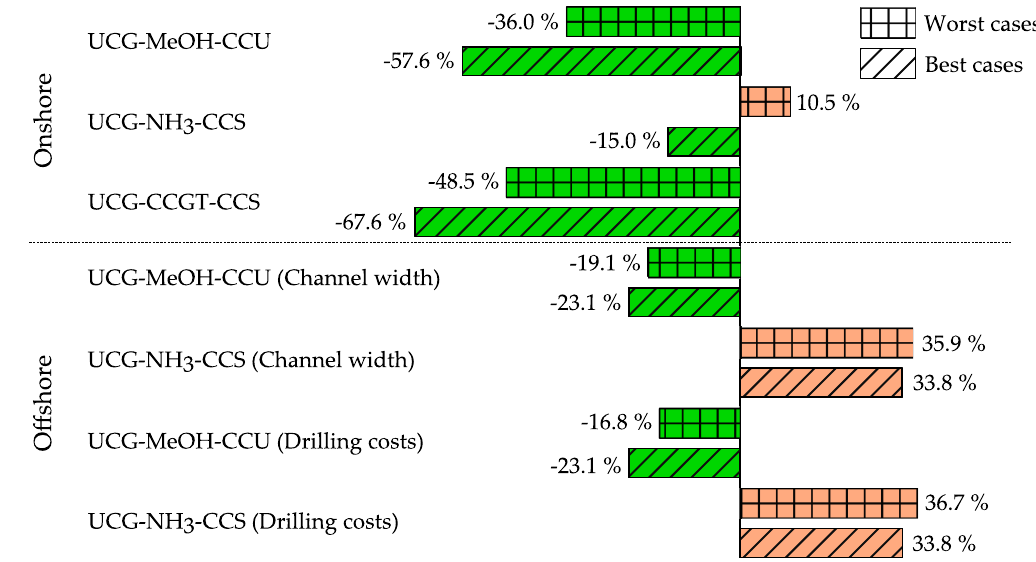
Figure 8. Percentage variation of the best- and worst-case costs in the underground coal gasification-based onshore (electricity, methanol, ammonia production) and offshore scenarios (methanol and ammonia production) to the current market